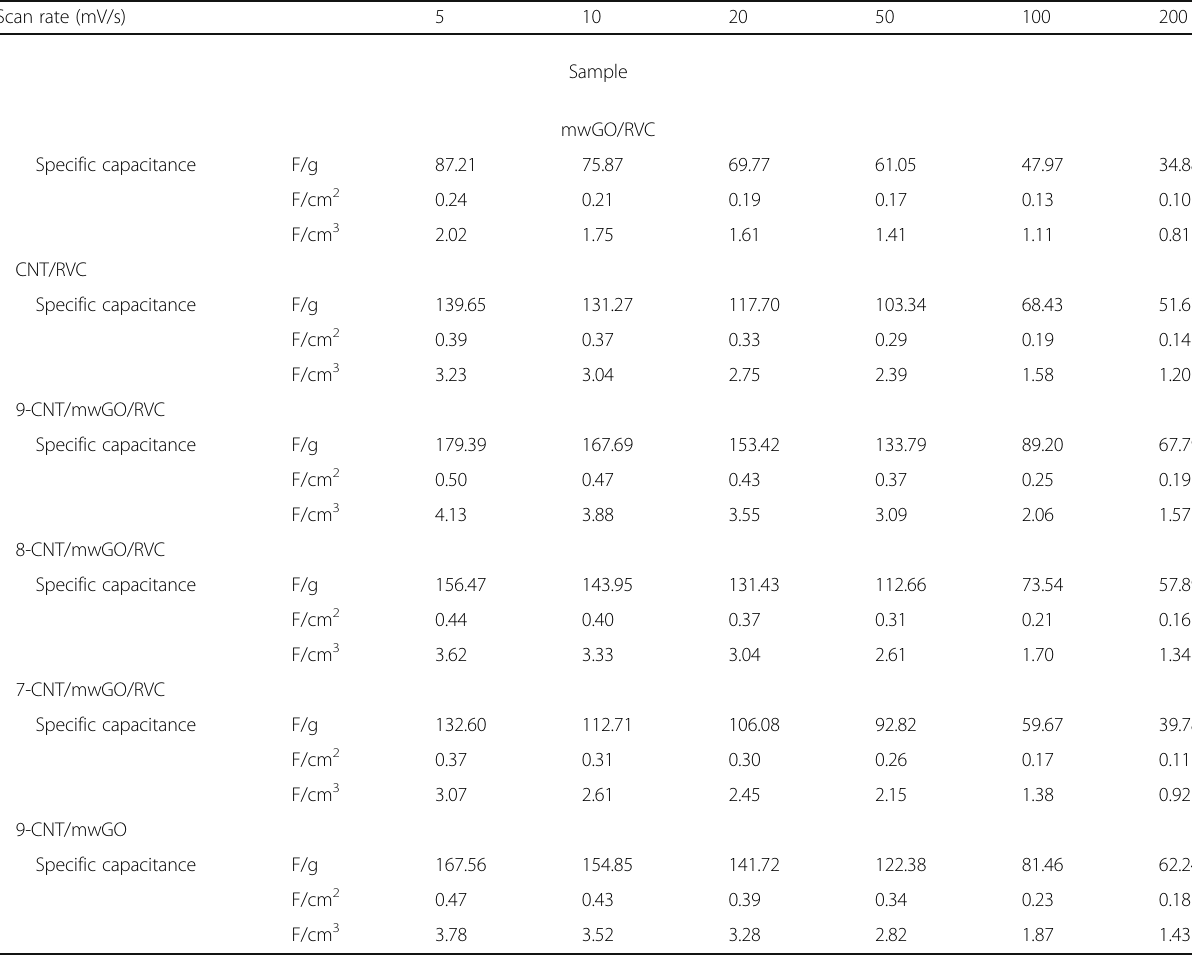
Table 2 Specific capacitance value of different electrodes measured with respect to mass (F/g), area (F/cm 2 ), and volume (F/cm 3 ) Scan rate